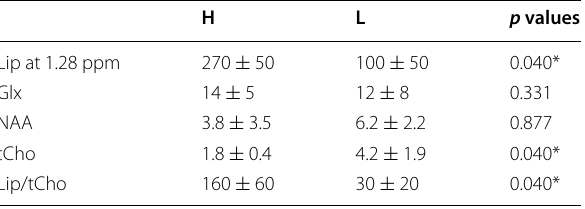
Metabolite concentrations are expressed in mM Glx Sum of glutamate (Glu) and glutamine (Gln), Lip Lipids, Lip/tCho Ratio between lipids and total choline, NAA N -acetylaspartate, tCho Total choline *Indicates statistically significant values (Mann-Whitney U test)